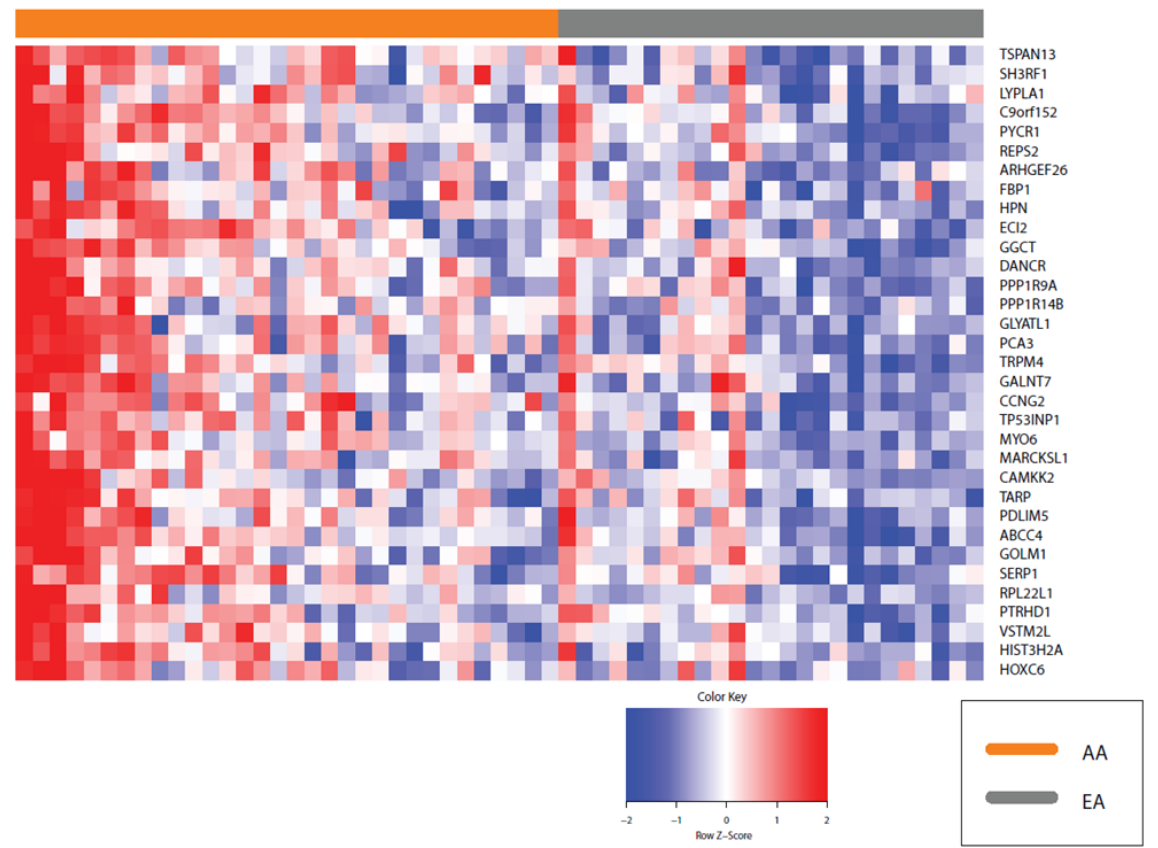
Figure 6. Heat map of gene expression changes in EA men compared with AA men for transcripts that map to the co-expression signature ‘Genes up-regulated in prostate cancer samples’. Red and blue boxes depict relative over- and under-expression with regard to a reference set as the mid-point all patients. Only significant transcripts ( q < 0.1) are shown.